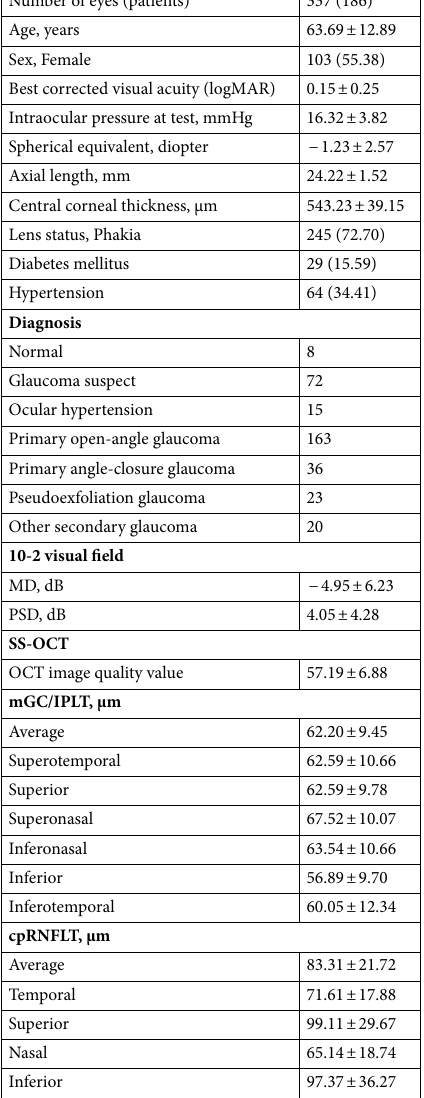
Table 2. Demographics and clinical characteristics of the test group. Values are presented as mean ± standard deviation (range) or number (%) unless otherwise indicated. logMAR logarithm of the minimum angle of resolution; MD mean deviation; PSD pattern standard deviation; SS-OCT swept-source optical coherence tomography; mGC/IPLT macular ganglion cell/inner plexiform layer thickness; cpRNFLT circumpapillary retinal nerve fiber layer